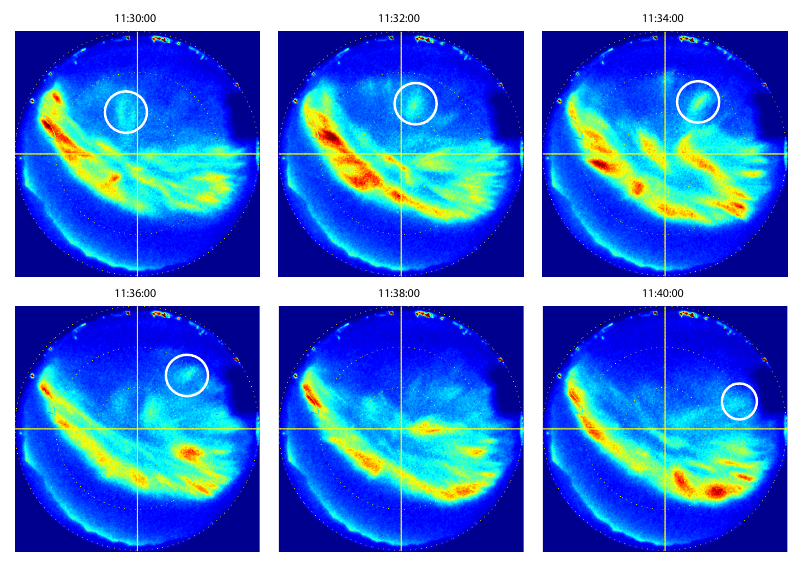
Fig. 3. ASC image sequence at 630.0nm for the interval 11:30–11:40 UT. The coordinate system is zenith angle vs. azimuth angle with respect to magnetic north. The central vertical line (yellow) marks the 15:00 MLT meridian. Magnetic north is up and west to the left in each image. Latitudinally separate forms have been marked A, B, and